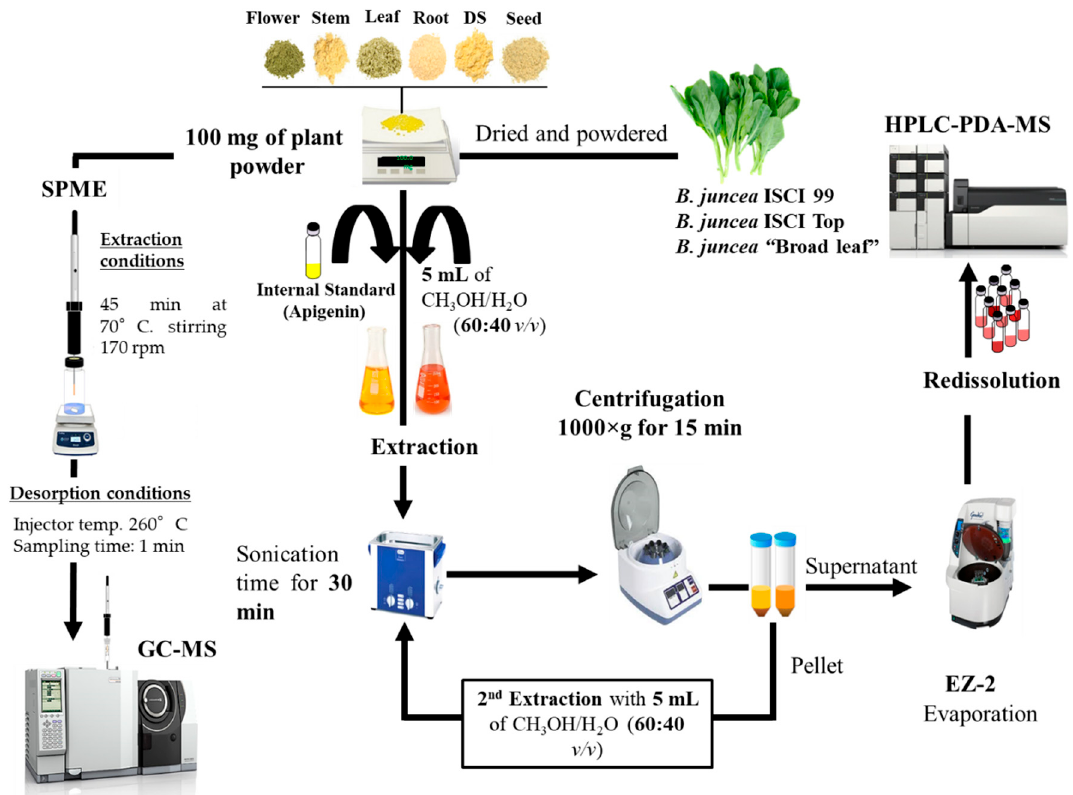
Figure 4. Extraction of the metabolite content of B. juncea cultivars prior to HPLC-PDA-MS / MS analyses.